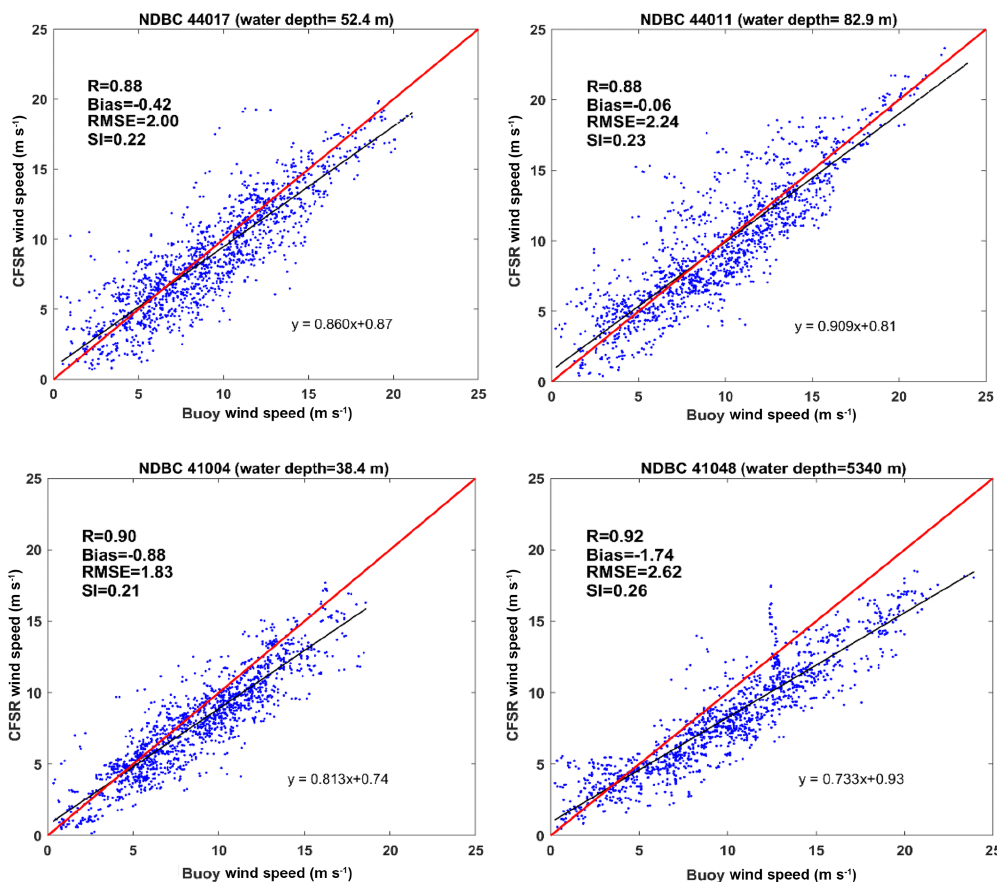
Figure 4. Evaluation of the CFSR wind field versus measured wind by NDBC buoys at four stations shown in Fig. 1.